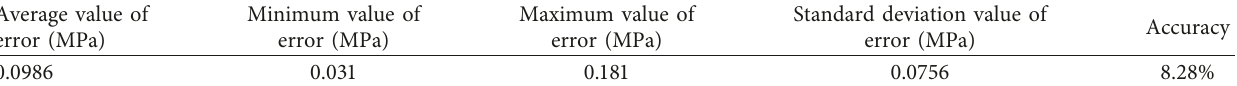
Table 5: Statistical indices of the error in the mechanical strength (50 sets of error